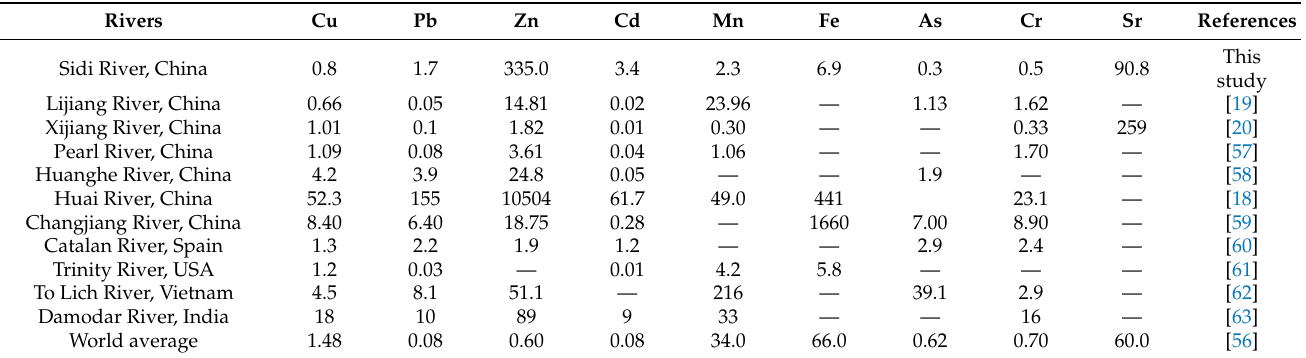
Table 4. Comparison of the concentrations of dissolved heavy metals ( µ g/L) in the Sidi River’s water with other rivers in the world.